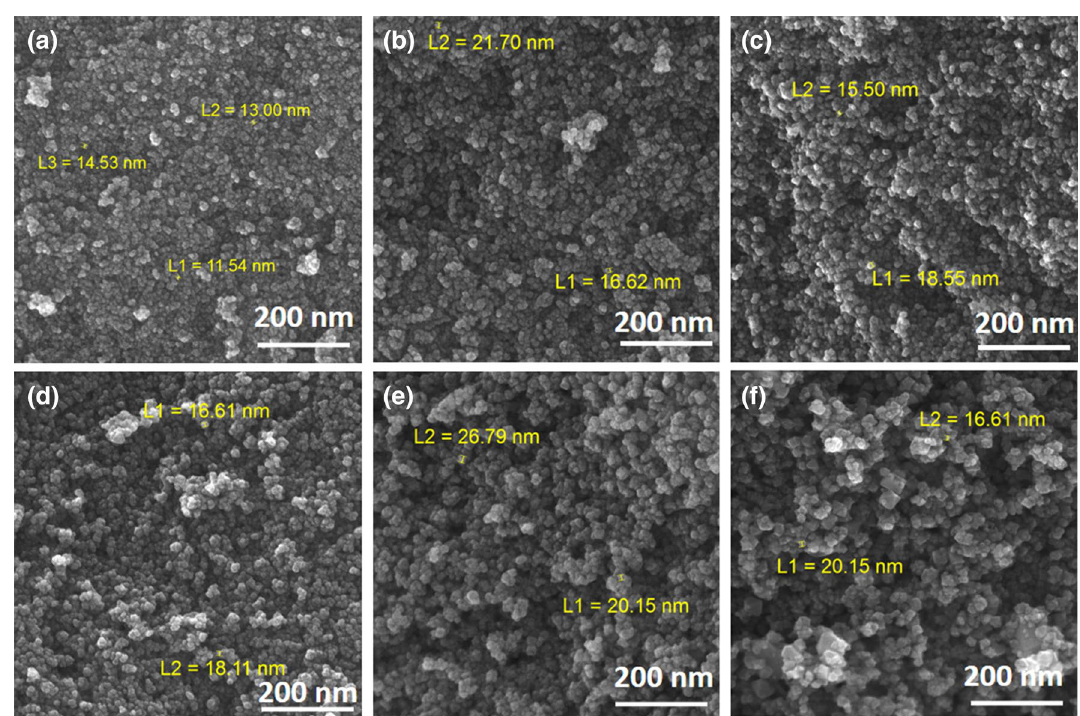
Figure 7. FESEM images of the prepared Ni 1−x Mn x Fe 2 O 4 nanoparticles, where ( a ) x = 0, ( b ) x = 0.2, ( c ) x = 0.4, ( d ) x = 0.6, ( e ) x = 0.8, and ( f ) x =